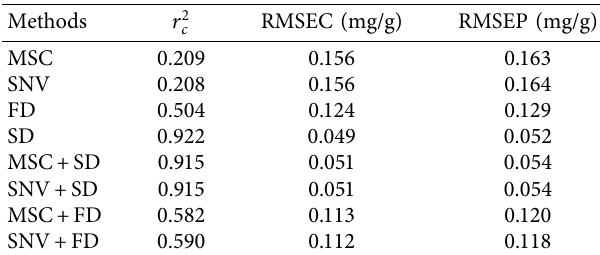
Table 4: The results for the data preprocessing